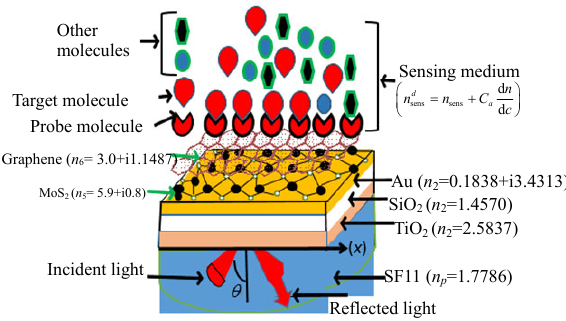
Fig. 1 Schematic diagram of the proposed SPR biosensor, where the MoS 2 layer is coated on Au film (thickness d Au is 50 nm to maintain both high detection accuracy and quality factor we have considered gold layer thickness of 50 nm throughout the analysis. Another point would be the fluctuating nature of SPR angle except 50 nm, which suggests difficulty to find out a stable sensing stage) and monolayer graphene is coated on the lower MoS 2 layer as the biomolecular recognition